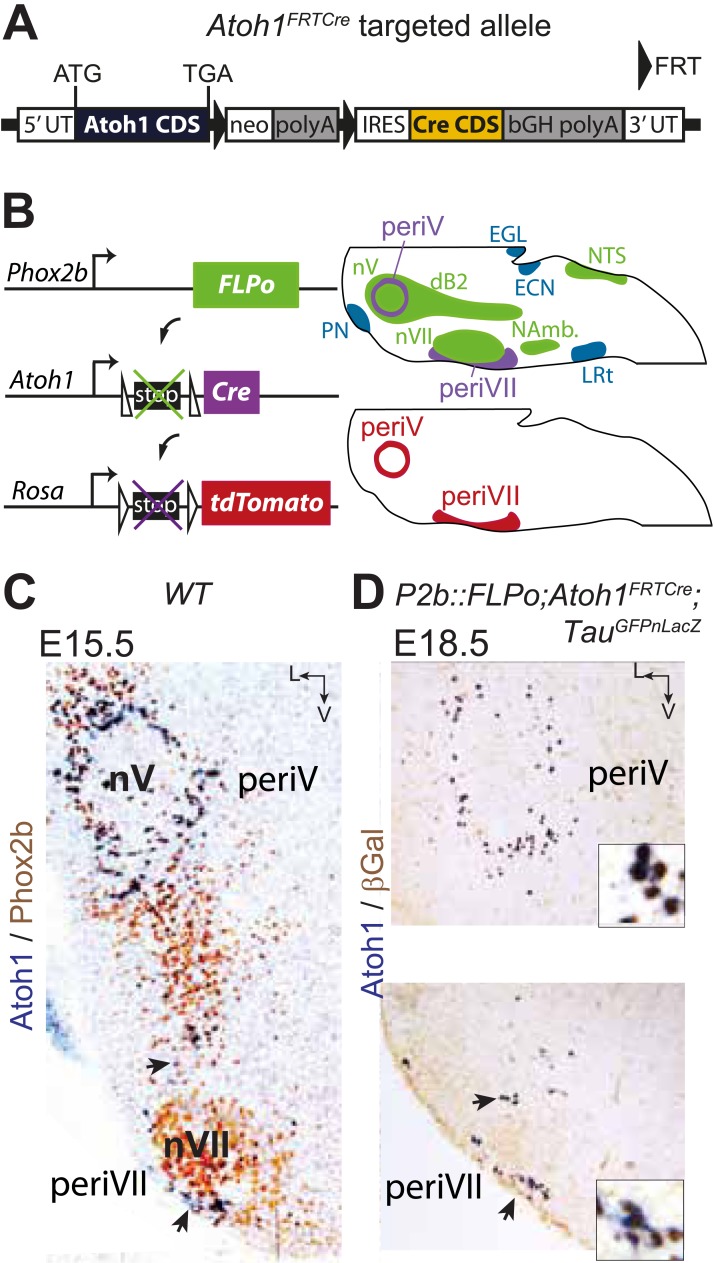
Targeting of Phox2bon/Atoh1on cells by intersectional genetics.(A) Schematic of the Atoh1FRTCre allele generated by homologous recombination in ES cells. The targeted Atoh1 locus contains from 5′ to 3′ the Atoh1 CDS up to and including the stop codon, a neomycin resistance cassette with three consecutive SV40 polyadenylation sequences flanked by FRT sites, an IRES sequence, the Cre recombinase CDS (orange) followed by a bovine growth hormone polyadenylation sequence and the Atoh1 3′ UTR. FLP recombinase-mediated recombination will remove the neomycin cassette with the polyadenylation signals allowing for expression of Cre from the Atoh1 locus. (B) Left, schematic of the P2b::FLPo (top) and Atoh1FRTCre (middle) alleles and the Cre recombinase-responsive R26tdTomato indicator allele (bottom). Right, top, sagittal brainstem cartoon schematizing the structures with a history of Phox2b (green) or Atoh1 (blue) (Rose et al., 2009a and data not shown) expression and the intersectional population expressing or having expressed both (purple). Below, the periV and periVII cells that will express tdTomato in P2bFLPo;Atoh1FRTCre;R26tdTomato embryos (red). The cells expressing FLPo recombinase from the Phox2b promoter will activate Cre expression from the Atoh1 locus in the intersectional population, which in turn will activate tdTomato expression (or nuclear βgalactosidase expression if TauGFPnLacZ is used as indicator allele). EGL, external granular layer, ECN, external cuneate nucleus, LRt, lateral reticular nucleus, NAmb., nucleus ambiguus, NTS, nucleus of the solitary tract, PN, pontine nuclei. (C and D) Combined ISH for Atoh1 and IHC for Phox2b (C) or nuclear βgalactosidase (D) on coronal sections through the hindbrain from E15.5 wild-type (WT) (C) or E18.5 P2b::FLPo;Atoh1FRTCre;TauGFPnLacZ (D) embryos. The periV and periVII cells are the only cells in the brainstem co-expressing Phox2b and Atoh1 (C) and also the only cells with a history of both Phox2b and Atoh1expression (D). The arrows in panels C and D point to the periVII cells. The insets in panel D show close ups of periV (top panel) and periVII cells (bottom panel), double-labeled for Atoh1 and βgalactosidase.